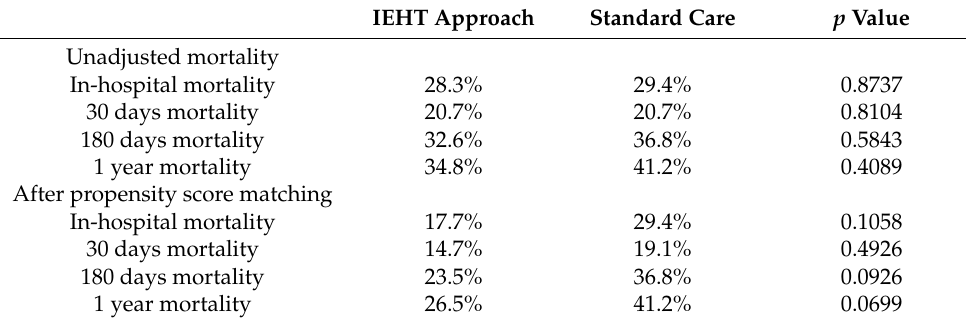
Table 5. Outcome IEHT approach versus standard